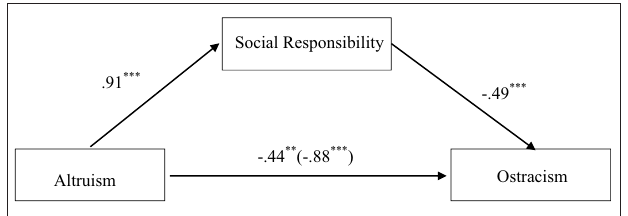
FIGURE 1 | Mediating role of social responsibility in study 3. Note : ** p < 0.01; *** p < 0.001.